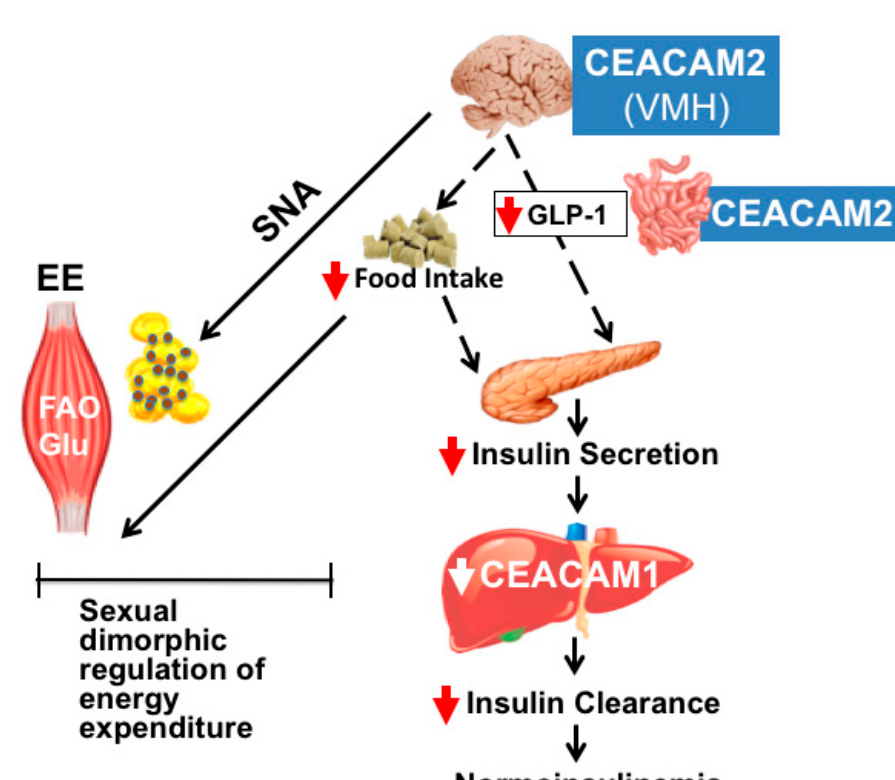
Figure 1. Metabolic role of CEACAM2. SNA, sympathetic nervous activity; EE, energy expenditure; FAO, fatty acid β -oxidation; Glu, glucose.